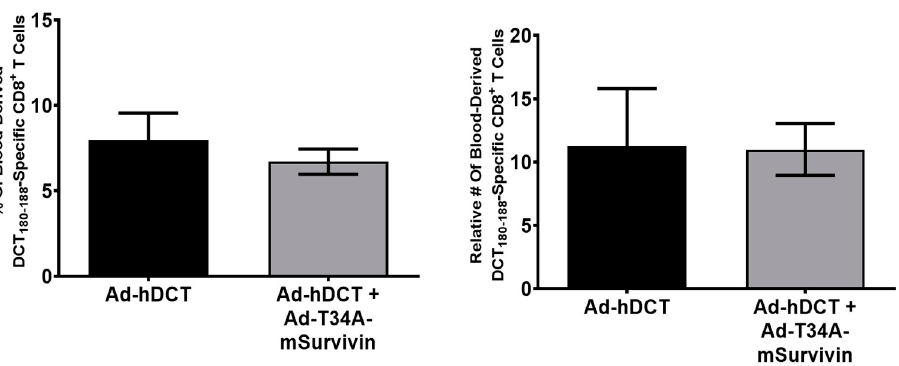
Figure 3. Co-vaccination against survivin and dopachrome tautomerase did not reduce the magnitude of a DCT-specific CD8 + T cell response when compared to DCT vaccination alone. Female C57BL/6 mice were vaccinated with Ad-hDCT, Ad-T34A-mSurvivin, or Ad-hDCT + Ad-T34A- mSurvivin at a total dose of 1 × 10 8 ifu intramuscularly. T cell responses were quantified ten days post-vaccination by flow cytometric assessment of intracellular cytokine staining after ex vivo re- stimulation with peptides. Blood-derived DCT 180–188 -specific CD8 + T cell response frequency ( left ) and total number ( right ) were not significantly different in mice vaccinated against DCT alone versus co-vaccination against DCT and murine survivin. Blood-derived mSurvivin 53–67 specific CD8 + T cell responses were not detectable (data not shown). Significance was determined by one-way analysis of variance with Tukey’s multiple comparison test ( n =